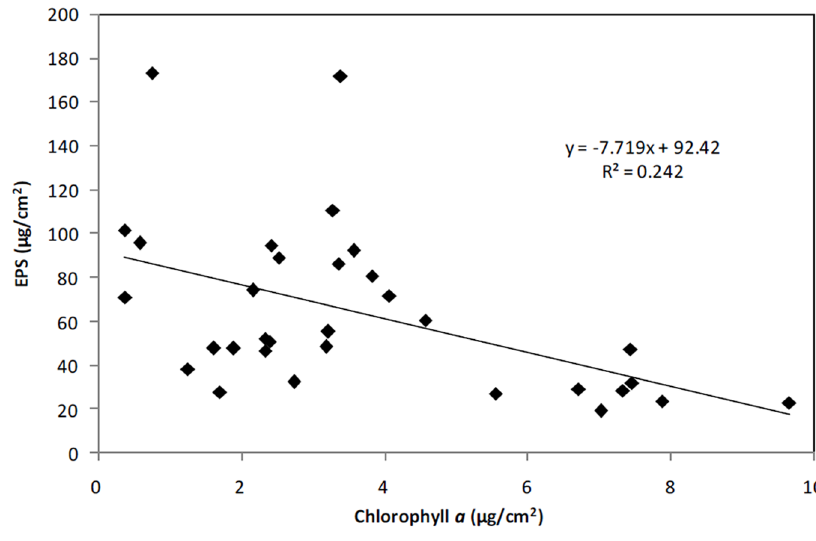
Figure 4. Relationship between chlorophyll a and exopolysaccharides (EPS).